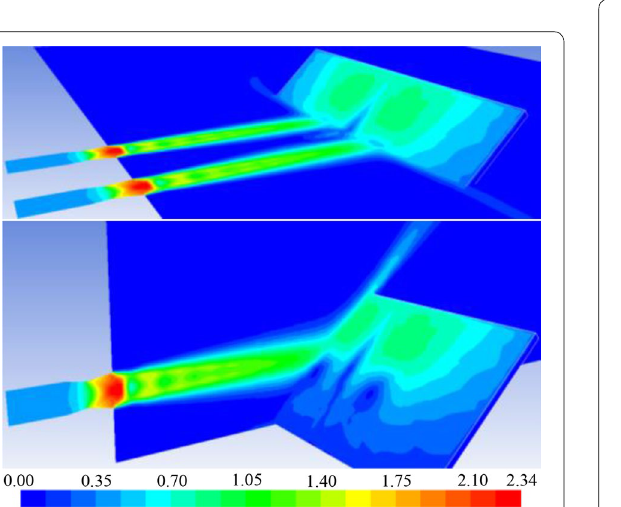
Figure 17 Total temperature contour of gas jet from twin